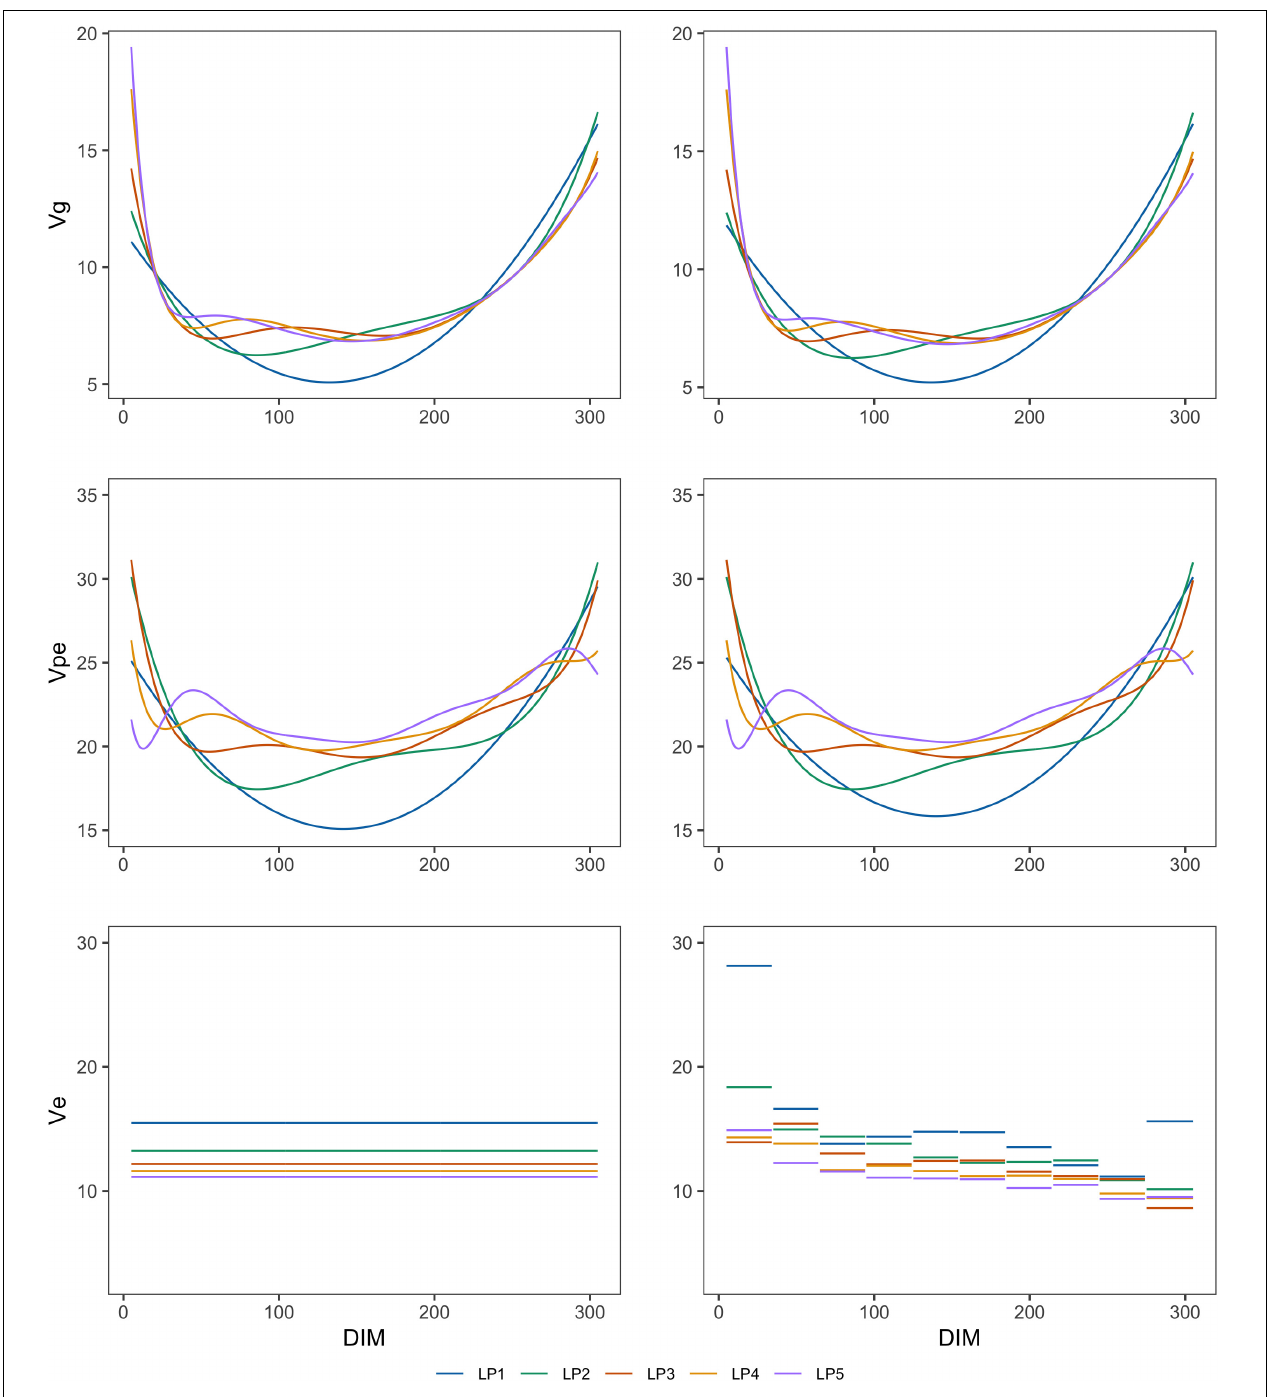
FIGURE 1 | Genetic variances (Vg), permanent environmental variances (Vpe), and residual variances (Ve) at each test day along the lactation from models with different orders of LP based on assumption of homogeneous (left column) or heterogeneous residual variance (right column).